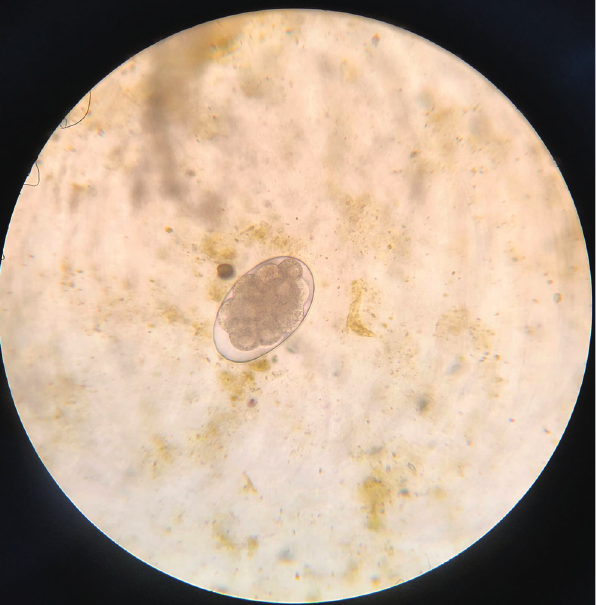
Figure 4: Nematodirus : the egg is ovoid, colorless, and thin-shelled, measuring approximately 210 μ m × 100 μ